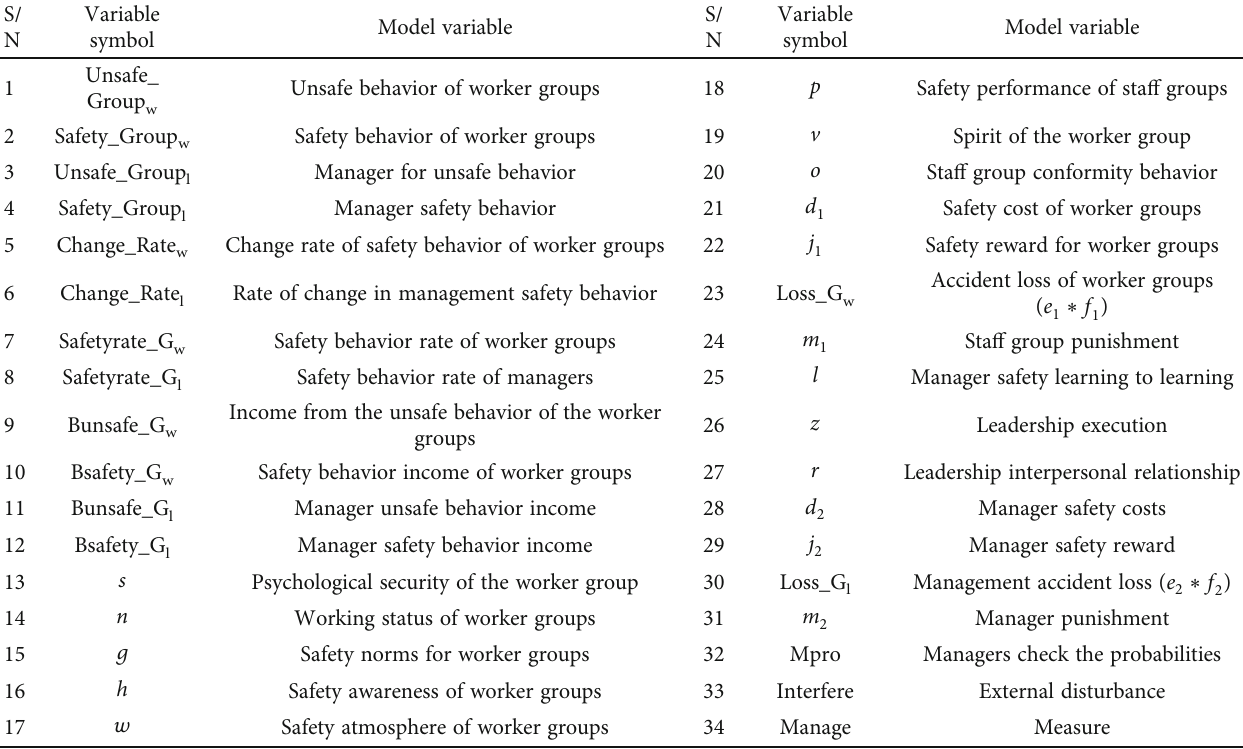
Figure 6: Manager-worker group safety behavior game SD model. Table 4: SD model variable symbol information